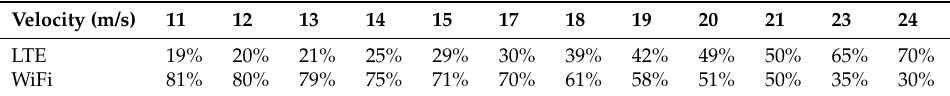
Table 3. Mobile user equipment (UE) behavior in HetNets according to